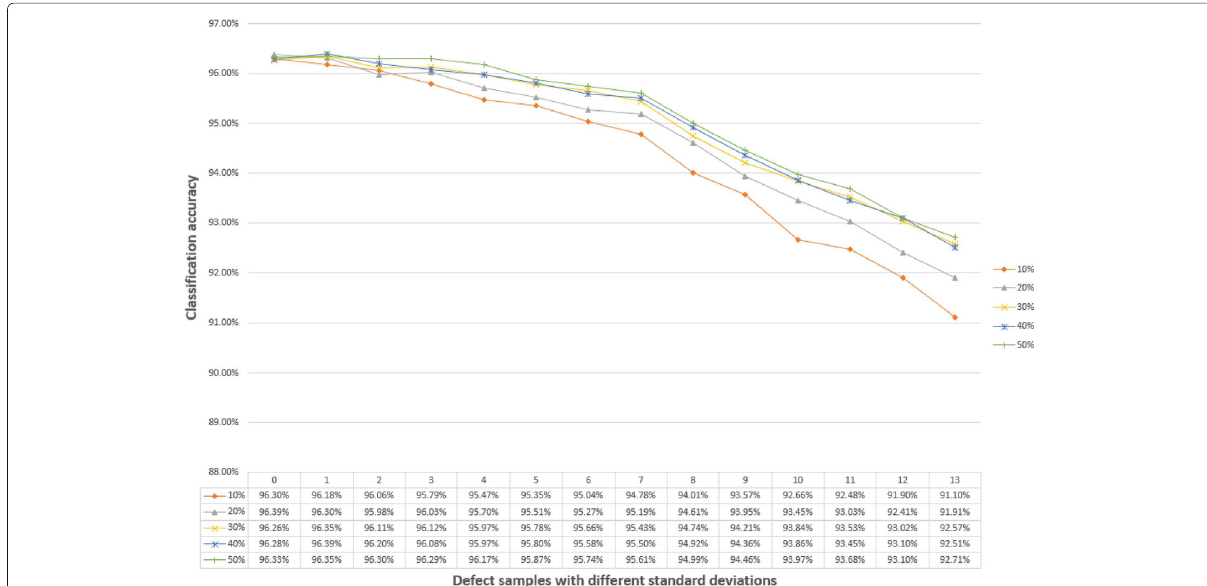
Fig. 10 Accuracy of BYEC classifiers adjusted by different sizes (0.1, 0.2, 0.3, 0.4, 0.5, and 0.6) on the defect samples with different standard deviations ( 0 − 13